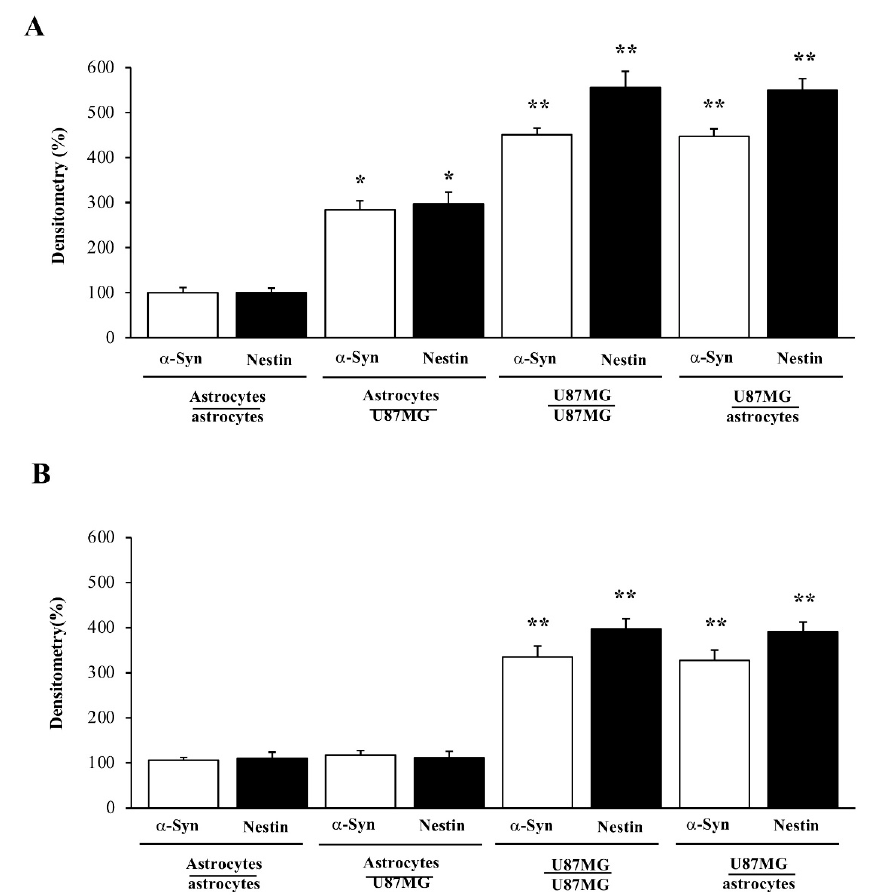
Figure 11. Densitometry of α -syn and nestin expression in co-cultures of astrocytes and GBM cells in baseline conditions and following rapamycin administration. Graphs report densitometry for α -syn and nestin immuno-fluorescence in co-cultures of astrocytes and GBM cells, both in baseline conditions ( A ), and following 100 nM rapamycin administration ( B ). These data are obtained from astrocytes co-cultured with astrocytes, astrocytes co-cultured with GBM cells, GBM cells co-cultured with GBM cells, and GBM cells co-cultured with astrocytes. Data are given as the mean percentage ± S.E.M. of optical density for each experimental group (assuming astrocytes co- cultured with astrocytes as 100%) obtained from N = 30 cells per group. * p < 0.05 compared with astrocytes co-cultured with astrocytes; ** p < 0.05 compared with astrocytes co-cultured with GBM cells.